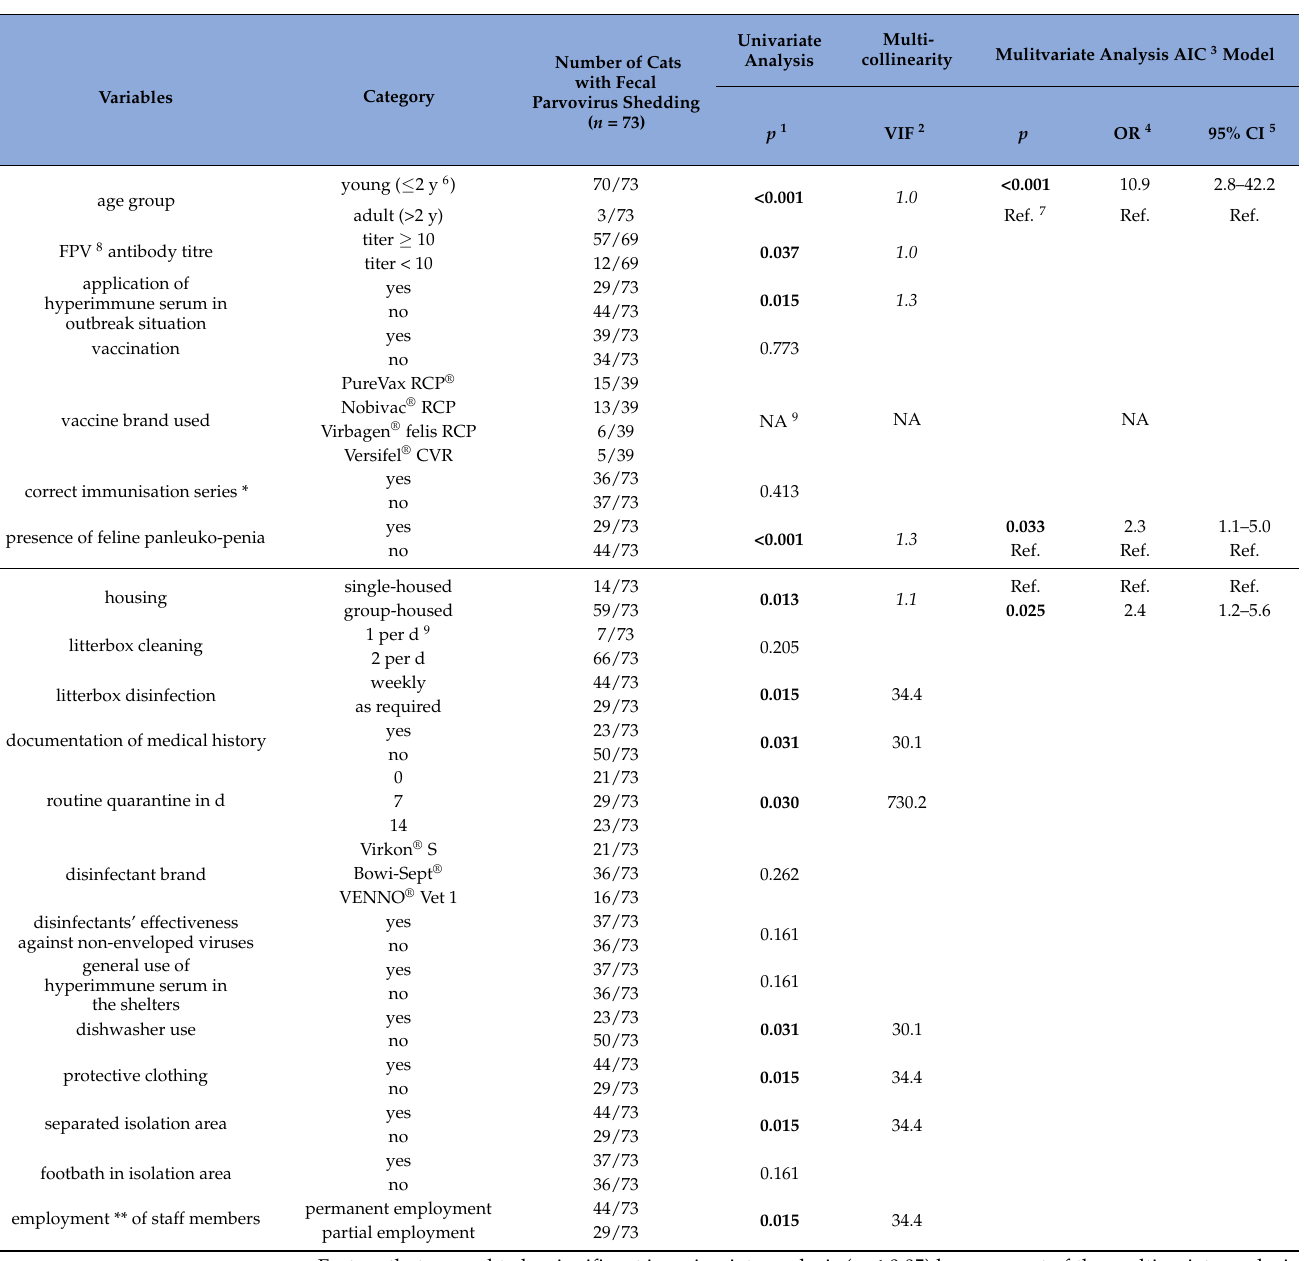
Table 3. Medical, husbandry, and hygiene risk factors associated with presence of fecal parvovirus shedding as detected by qPCR in uni- and multivariate